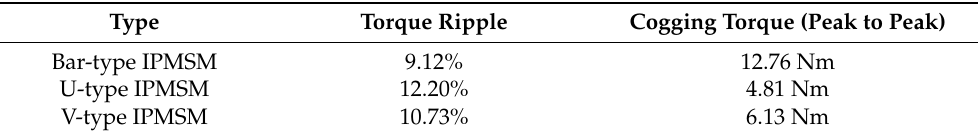
Table 2. Comparison of torque ripple and cogging torque at 1350 rpm.